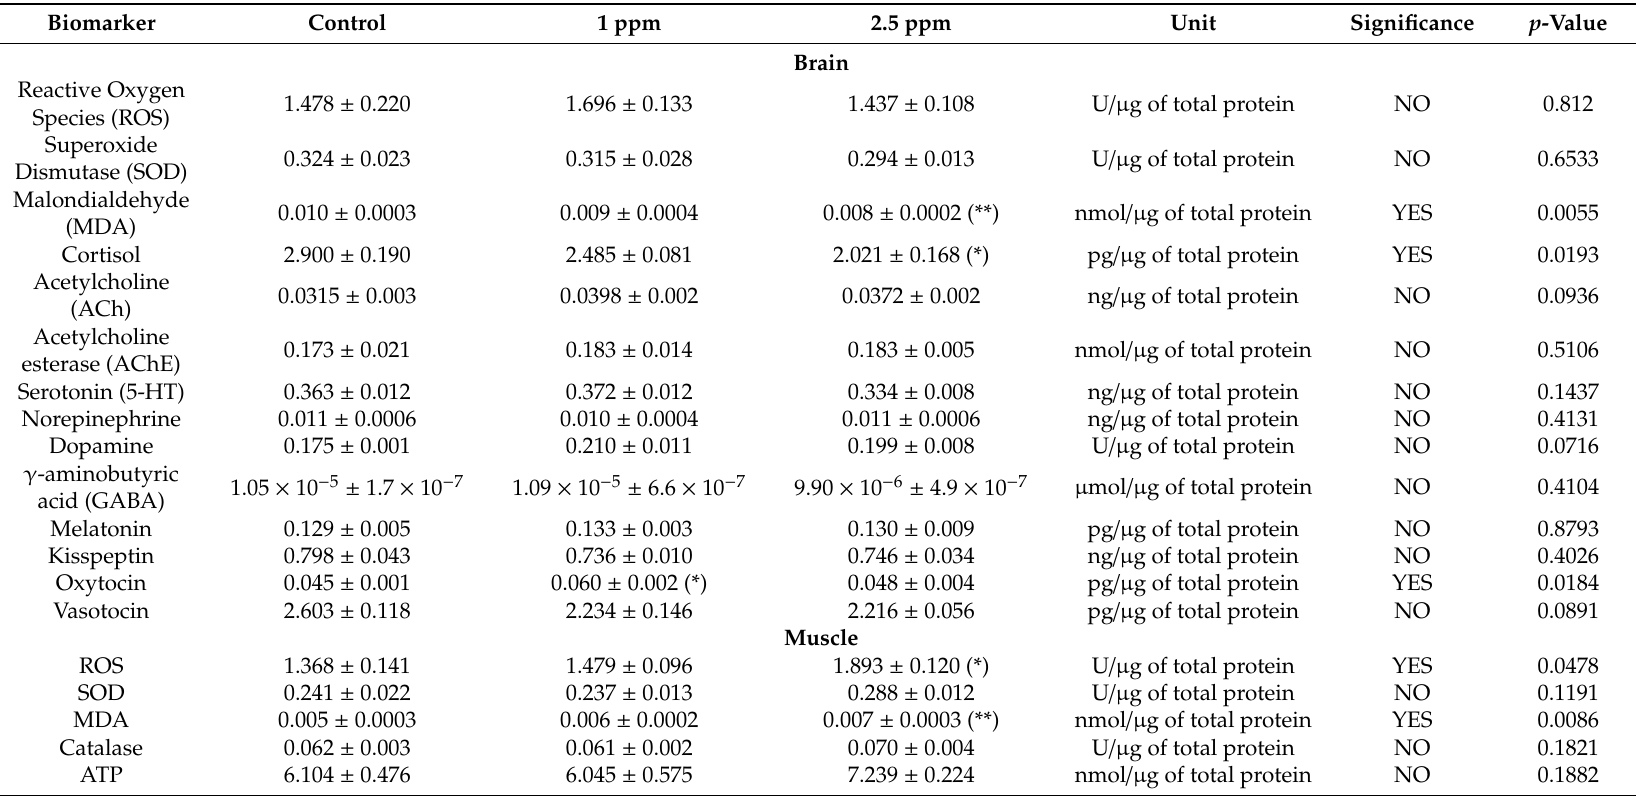
Table 1. Comparison of biochemical levels in brain and muscle tissue between control fish and donepezil-exposed fish by enzyme-linked immunosorbent assay (ELISA). Data are expressed as the mean ± SEM values and were analyzed by one-way ANOVA ( n = 3; * p < 0.05, ** p <